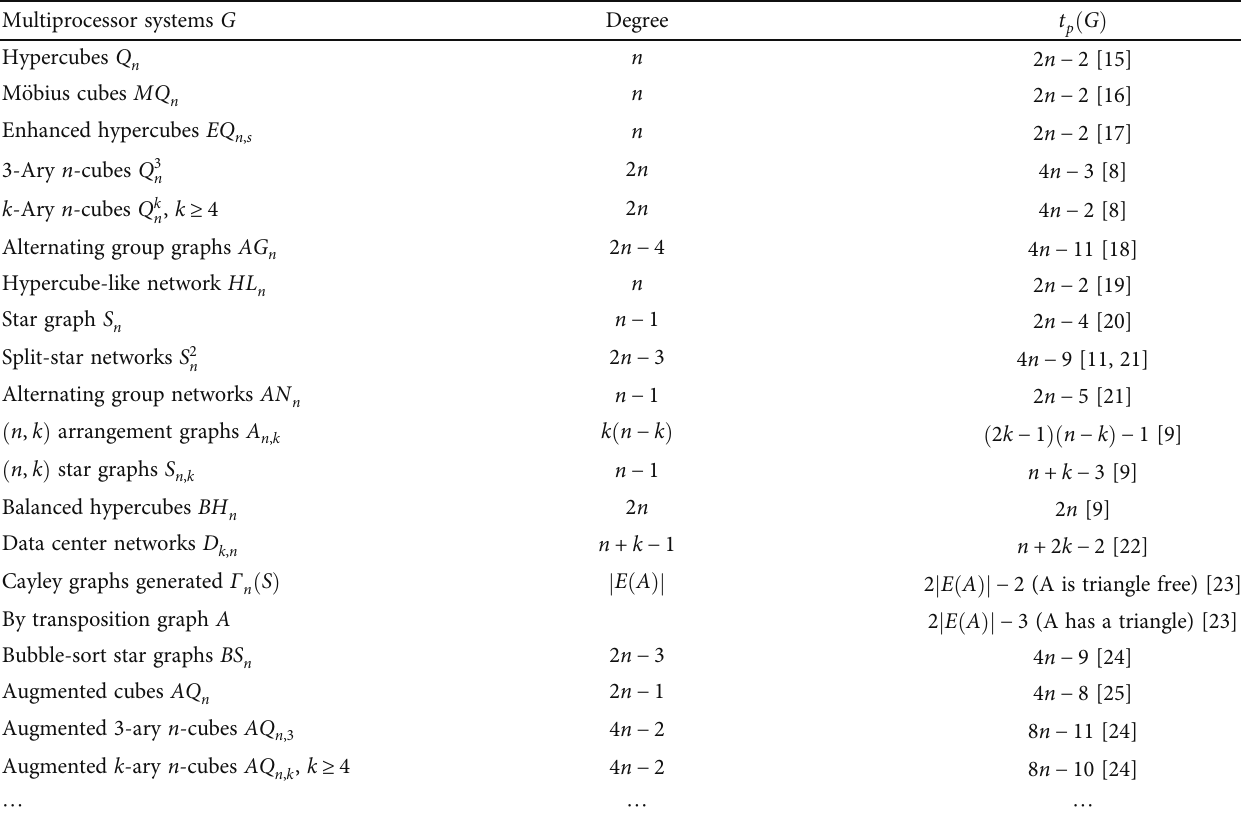
Table 1: Pessimistic diagnosability of several main multiprocessor